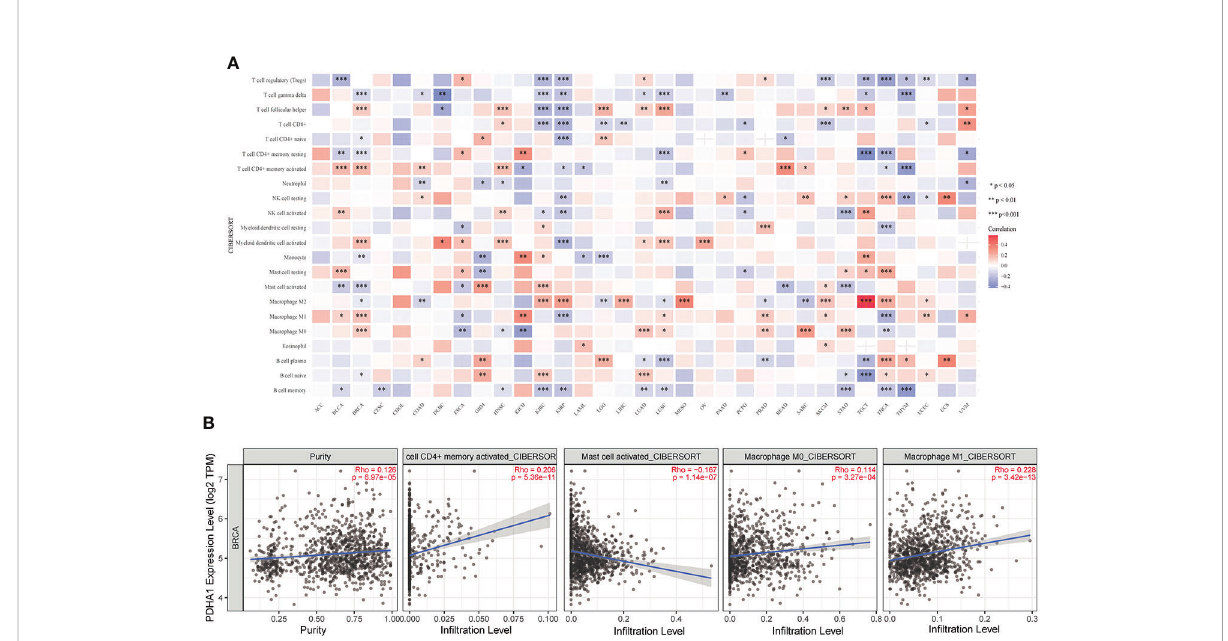
FIGURE 10 Correlation analysis of PDHA1 expression with immune cell in fi ltration analysis in BC. (A) The relationship between PDHA1 expression level and the in fi ltration levels of immune-related cells. (B) The scatter plots of relationship between PDHA1 expression and in fi ltration levels of immune-related cells by using TIMER2 database *P < 0.05, **P < 0.01, and ***P <